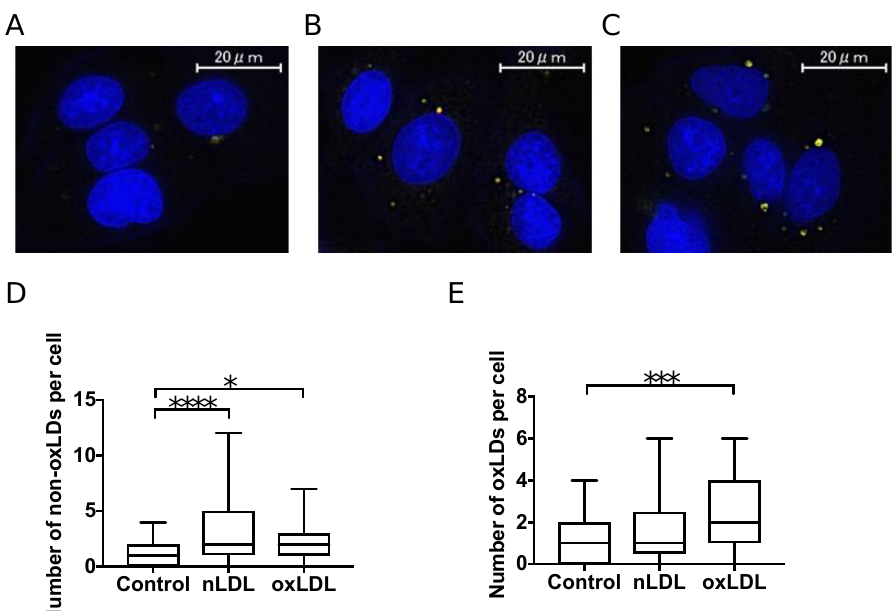
Figure 2. Evaluation of accumulation of neutral lipids and lipid hydroperoxides using fluorescence imaging. ( A – C ) Lipid droplets with neutral lipids and lipid hydroperoxides formed by C3A cells supplemented with ( A ) PBS, ( B ) 2.0 ng protein/ µ L nLDL, and ( C ) 2.0 ng protein/ µ L oxLDL (100 × ). ( D ) Number of non-oxidized lipid droplets (non-oxLDs) per cell analyzed using fluorescence imaging. ( E ) Number of oxidized lipid droplets (oxLDs) per cell analyzed using fluorescence imaging. Results were expressed as a box plot ( n = 53–84). One-way ANOVA with Kruskal–Wallis test, * p < 0.05, *** p < 0.001, **** p <